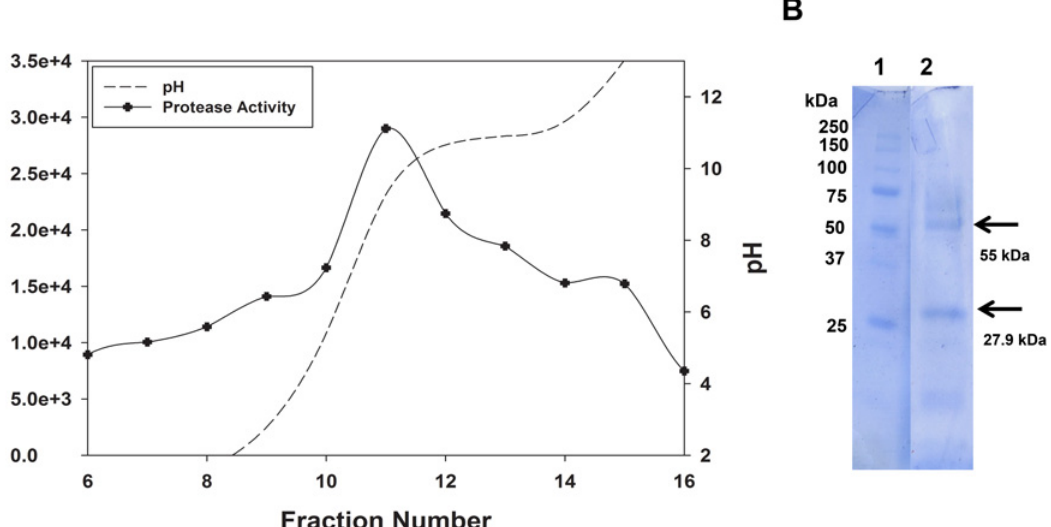
Fig 3. Preparative IEF separation and analysis of P . destructans extracellular proteins. Secreted proteins were recovered from MBN-G culture medium with broad-range ampholytes. Activity profile separated with broad-range ampholytes in the Rotofor cell (A). pH gradient indicated by dashed line. Protease activity assayed with FITC-casein: activity indicates fluorescence units per ml. Pooled activity peak fractions (10 – 13) resolved by SDS-PAGE and stained with Coomassie-brilliant blue.